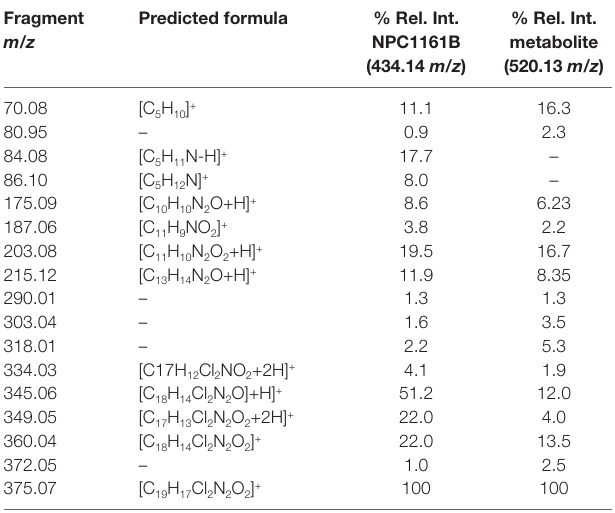
TABLE 1 | Fragment ion, predicted formula, and the relative intensity for each ion from NPC1161B and its metabolite. Fragment Predicted m/z